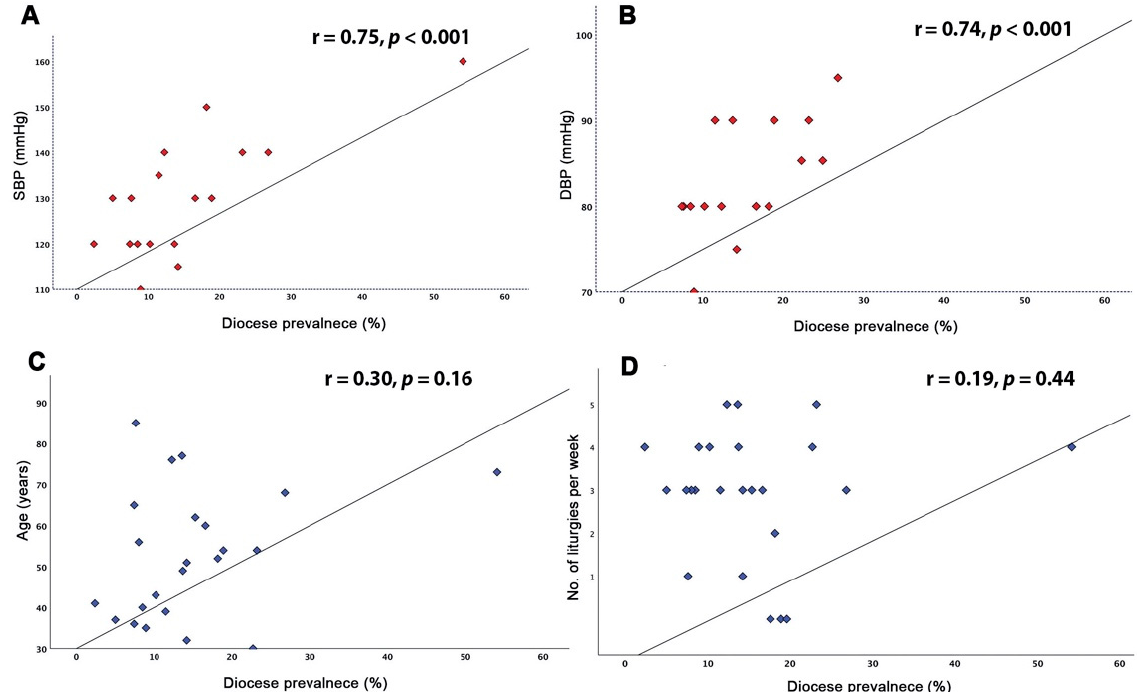
Figure 2. Relationship between risk factors and prevalence of COVID-19 among Clergy. ( A ) Disease prevalence with SBP; ( B ) disease prevalence with DBP; ( C ) disease prevalence with age; ( D ) disease prevalence with number of liturgies per week. SBP: systolic blood pressure; DBP: diastolic blood pressure.